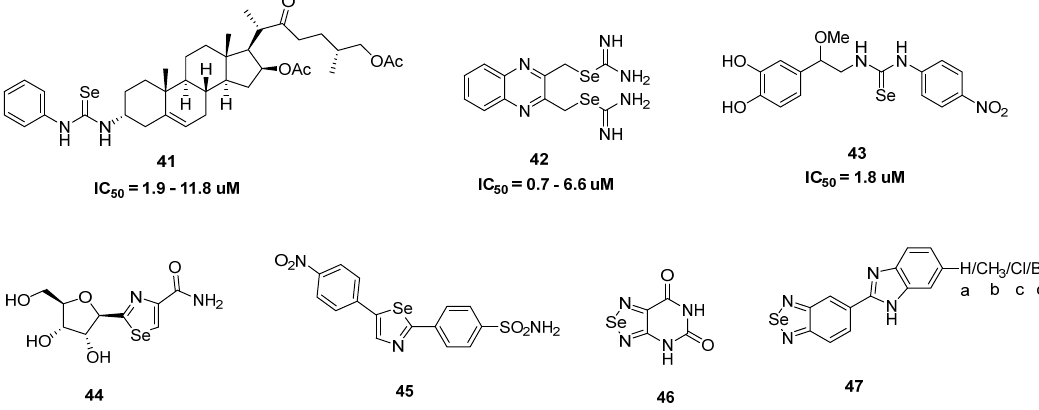
Figure 4. Structural representation of selenoureas ( 41 – 43 ) [84,85] and selenazoles ( 44 – 47 ) [86–89] for anticancer activity.